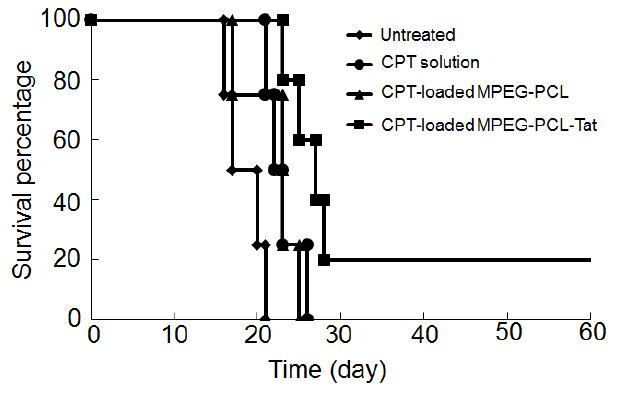
Figure 2. Kaplan-Meier survival curves of intracranial C6 glioma tumor bearing rats after no treatment (diamonds) or treatment with intranasal camptothecin (CPT) solution (circles), CPT-loaded MPEG-PCL (triangles) or CPT MPEG-PCL-Tat (squares). The 1.2 mg/kg as CPT dose were administrated to rats (n = 4–5).